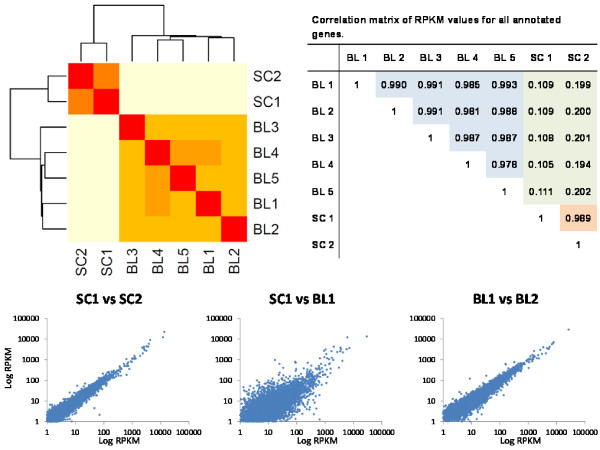
The heat map shows the segregation of samples by gene expression. Blastocyst (BL1 to BL5) and milk somatic cell (SC1 and SC2) transcriptomes are distinguished clearly from one another while grouping highly within their own sample types. Average correlation of RPKM for all annotated genes reflected this within BL (r > 0.97) and between sample groups (r < .21) and plotting of log-transformed RPKM values showed a much less linear relationship between milk somatic cells and blastocyst samples.